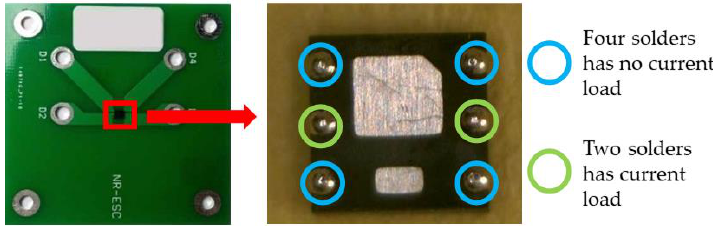
Figure 1. Schematic diagram and inner structure of BGA device.